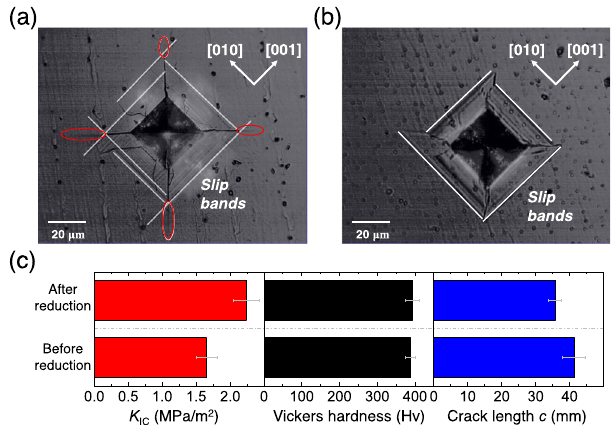
Fig. 6 | Results of indentation tests on {100} SrTiO 3 crystals before and after oxygen reduction. Indentation pictures of the SrTiO 3 crystal a before and b after the reduction process; c indentation fracture toughness K IC , Vickers hardness H V and crack length c measured in the indentation test (the error bars represent the standard deviations). Source data are provided as a Source Data fi